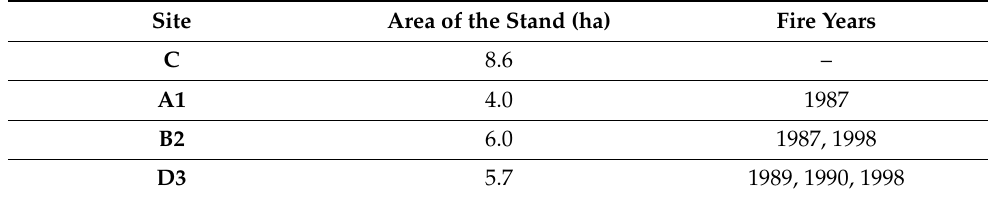
Table 1. Total area of stands and years of occurrence of fires. Site Area of the Stand (ha)